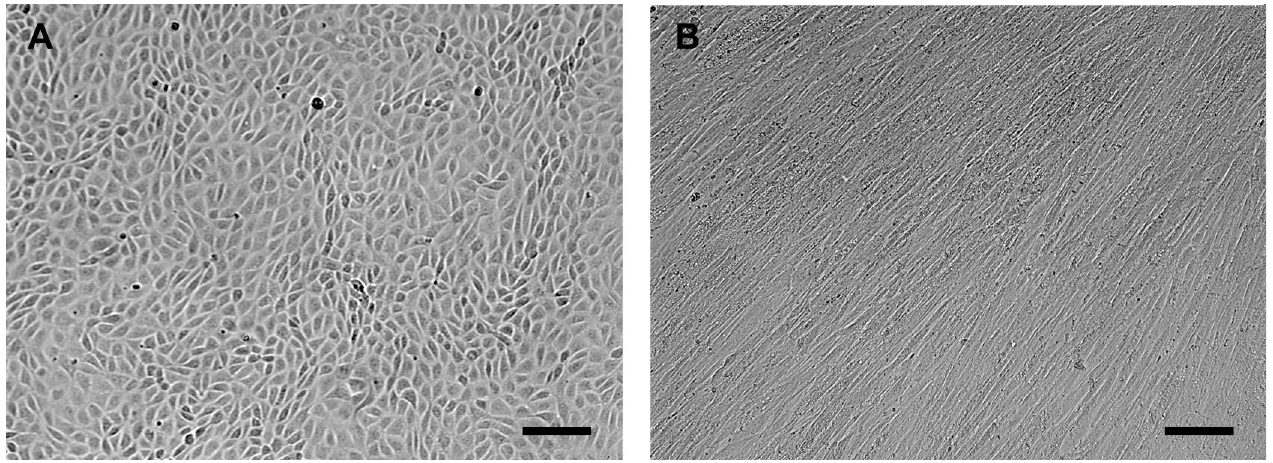
Fig 1. Morphology of fetal somatic cells. Representative micrograph image of (A) GREL cells and (B) fetal fibroblasts. The cell types were isolated from fetal ovaries with gestational ages of 56 days and 73 days, respectively. Bars: 100 μ m.